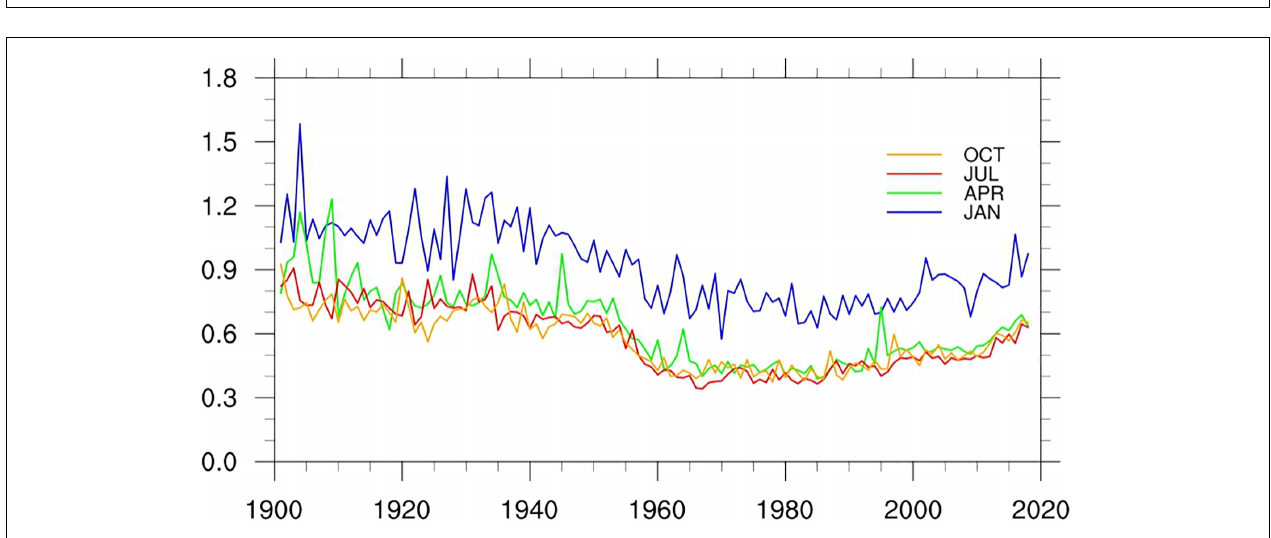
FIGURE 8 | Mean RMSEs of the LSAT anomaly from 1900 to 2018 for 4 months (January, April, July, and October).